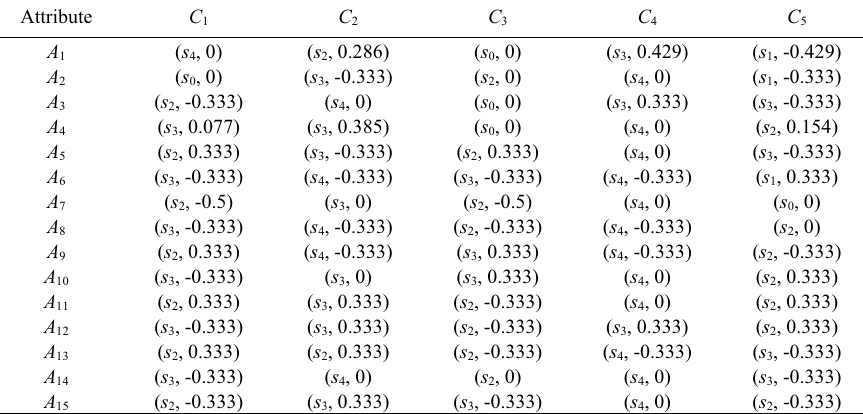
Table 12: The collective overall 2-tuple linguistic decision matrix Z